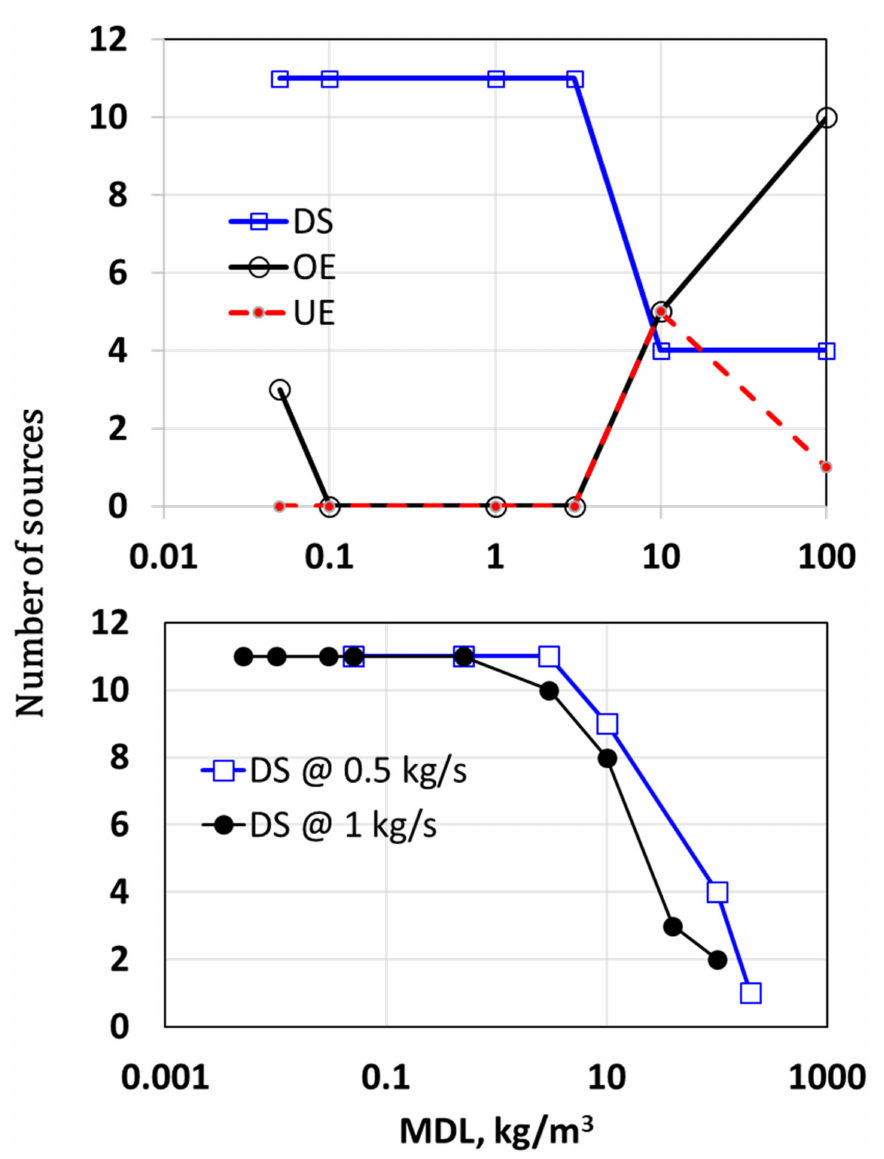
Figure A3. ( Top ): number of accurate leak locations (DS—blue squares), number of overestimated leaks (OE—black circles), and number of underestimated leaks (UE—red dots) as a function of MDL for the six detector array with a DR of 30 at a constant leak rate of 0.5 kg/s. ( Bottom ): number of accurate leak locations (DS) as a function of MDL for the six detector array with a DR of 1 at a constant leak rate of 0.5 kg/s (blue squares) and 1 kg/s (black